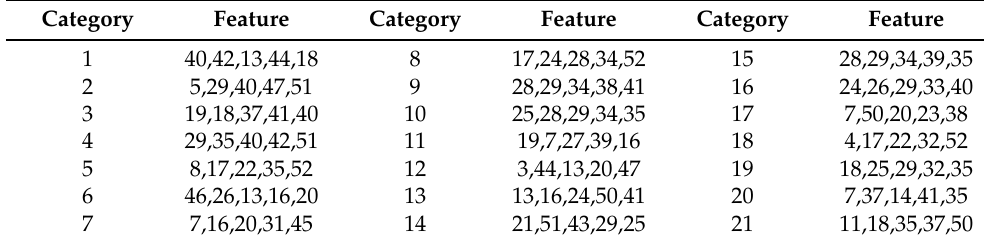
Table 5. Feature selection results of